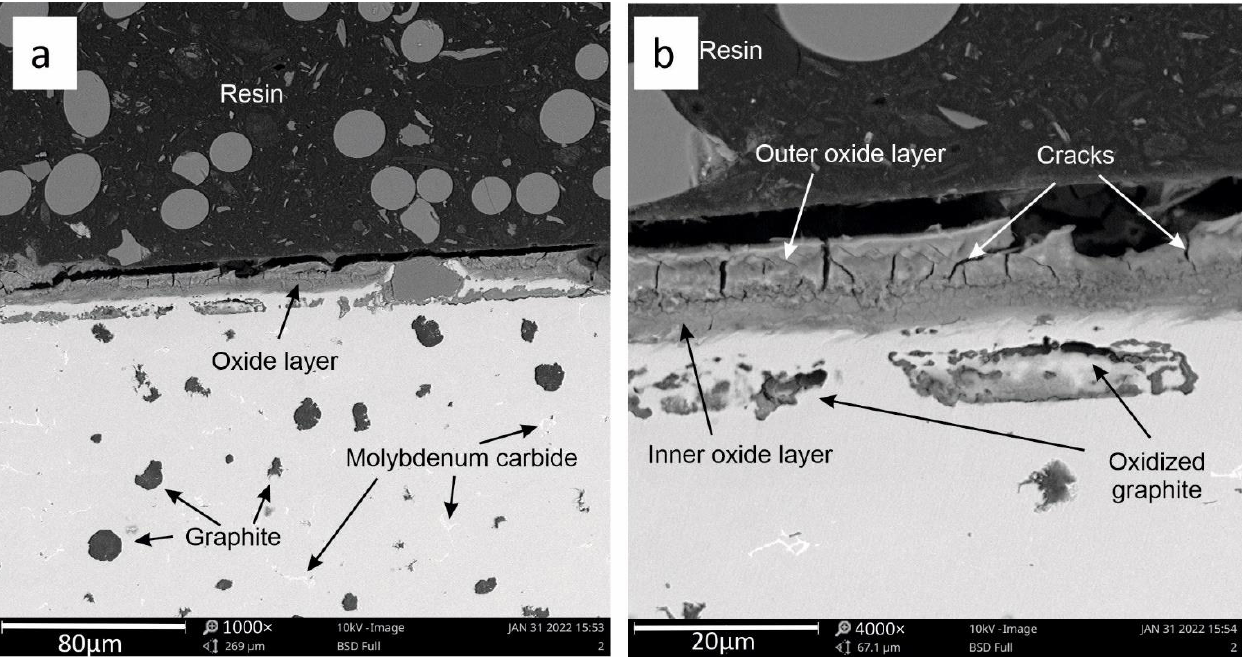
Figure 10. View of the oxide layer after three heating cycles ( a ) for sample 2. Detailed description of the oxide layer ( b